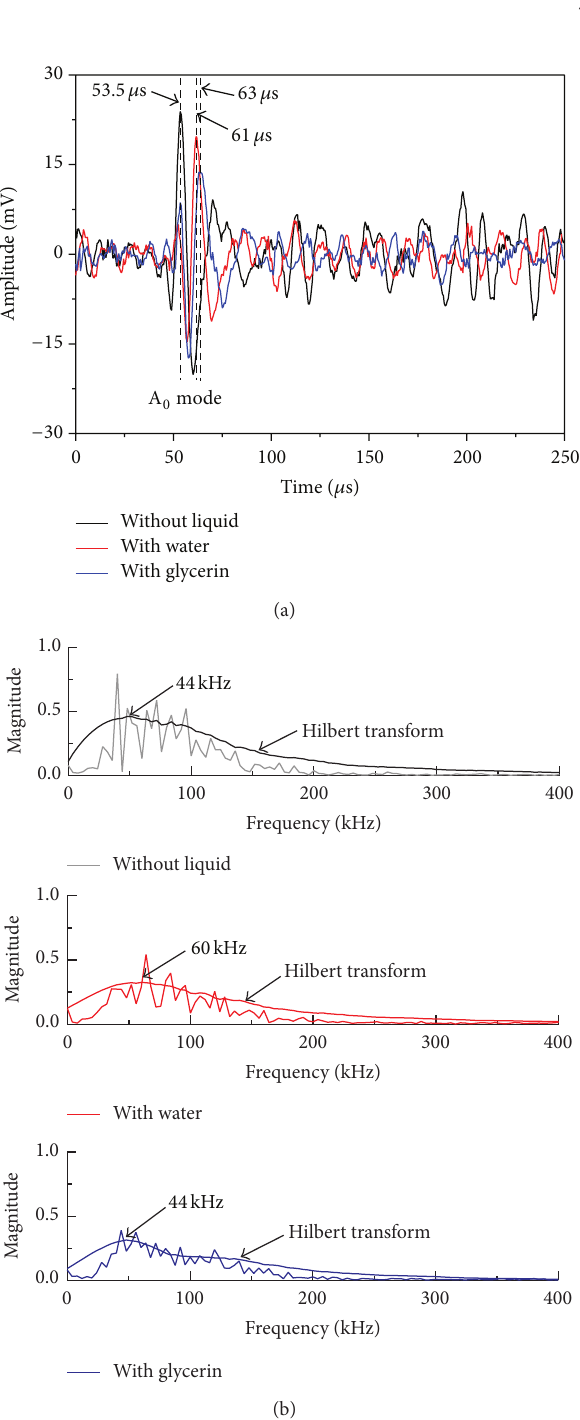
successfully visualized the wave propagation and showed damage evaluation capability for the submerged structural back surface crack. The 2 mm deep and 12 mm long back surface crack was evaluated by the proposed system as 11.29 mm in the water-immersed plate and 10.87 mm in the glycerin-immersed